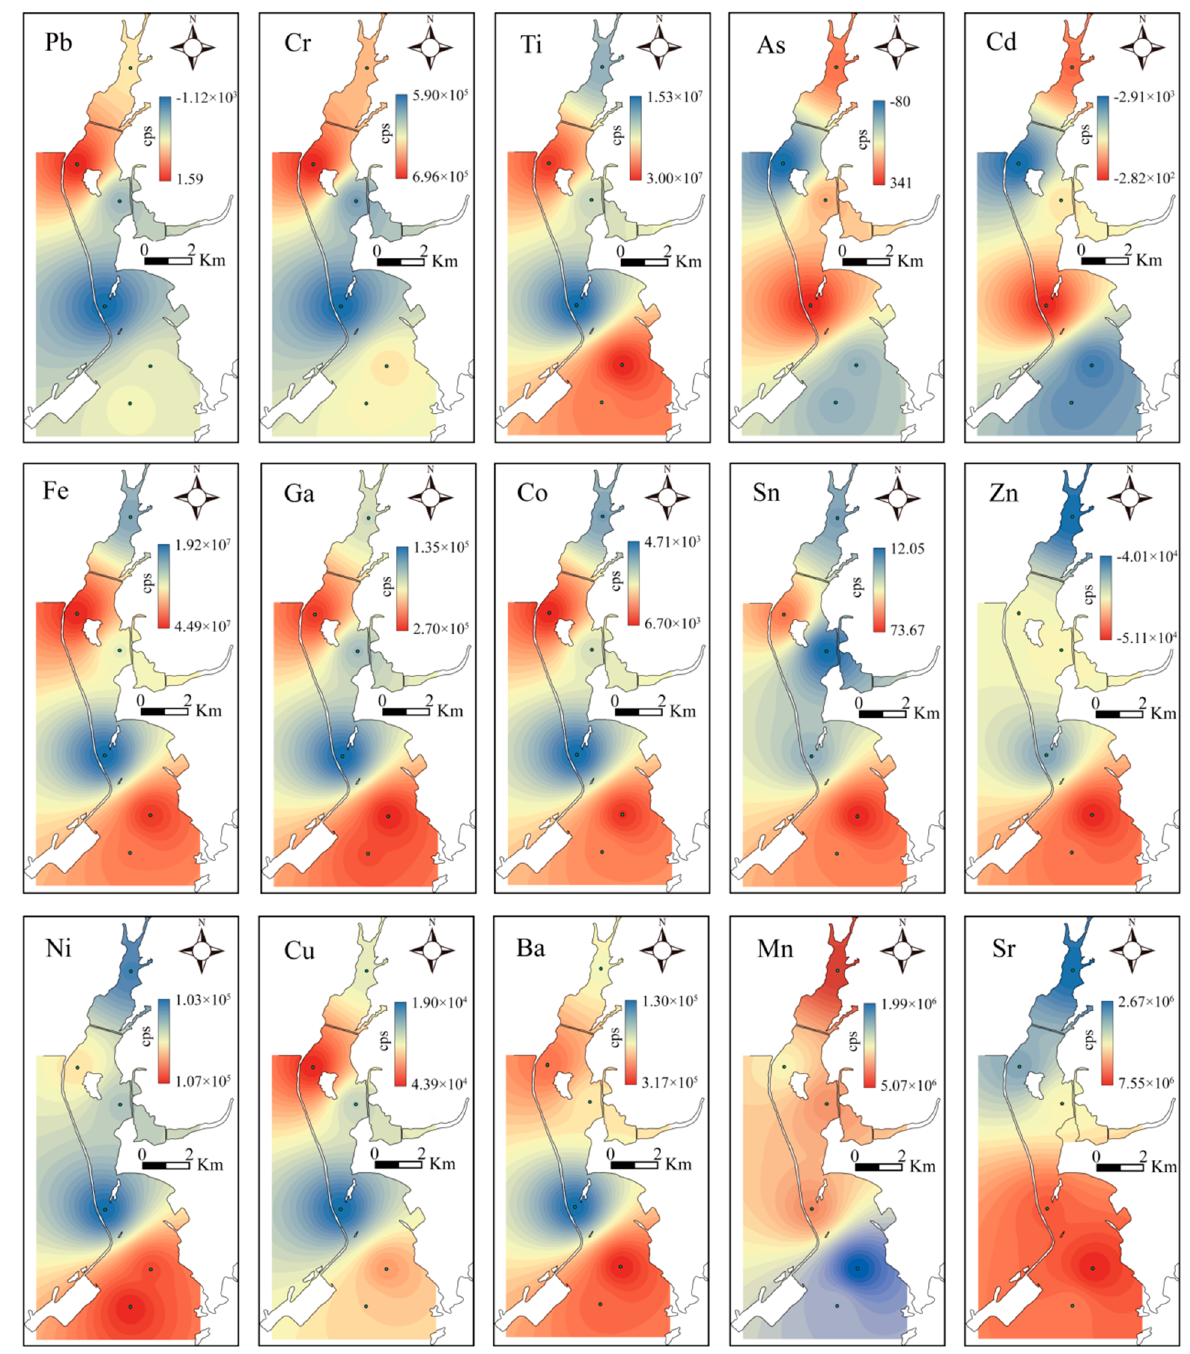
Figure 10. Spatial distribution of heavy metal elements of 24 sediment samples in the Lu’erhuan River Sea area of Qinzhou Bay, Guangxi Province.